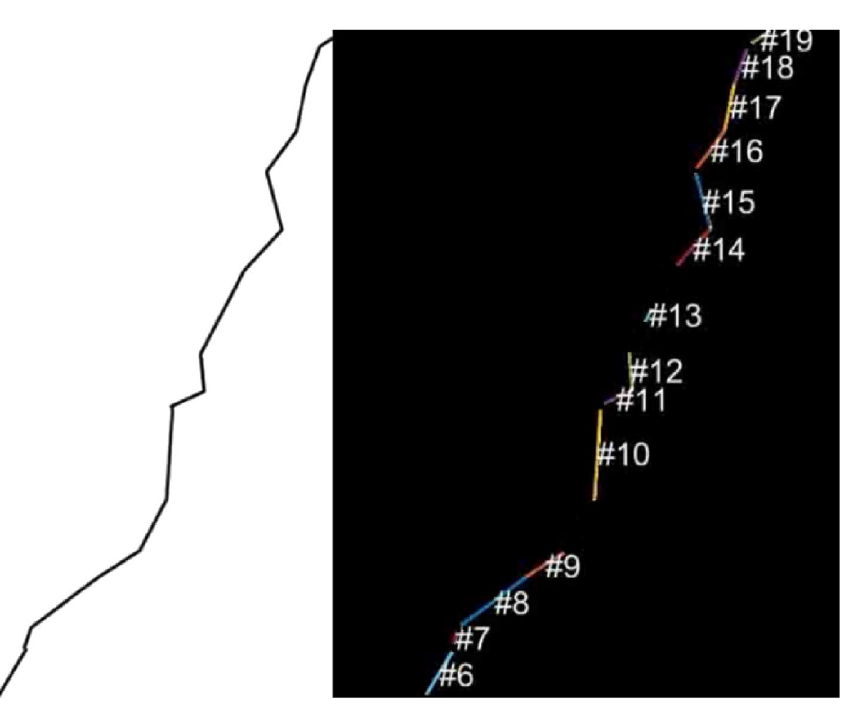
Figure 4. Example of failed Hough transform line